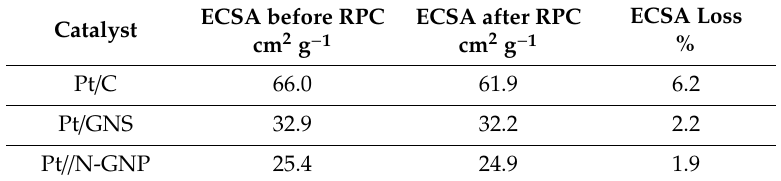
Table 3. Electrochemically active surface area (ECSA) values ECSA loss after RPC of Pt/C, Pt/GNS, and Pt//N-GNP.